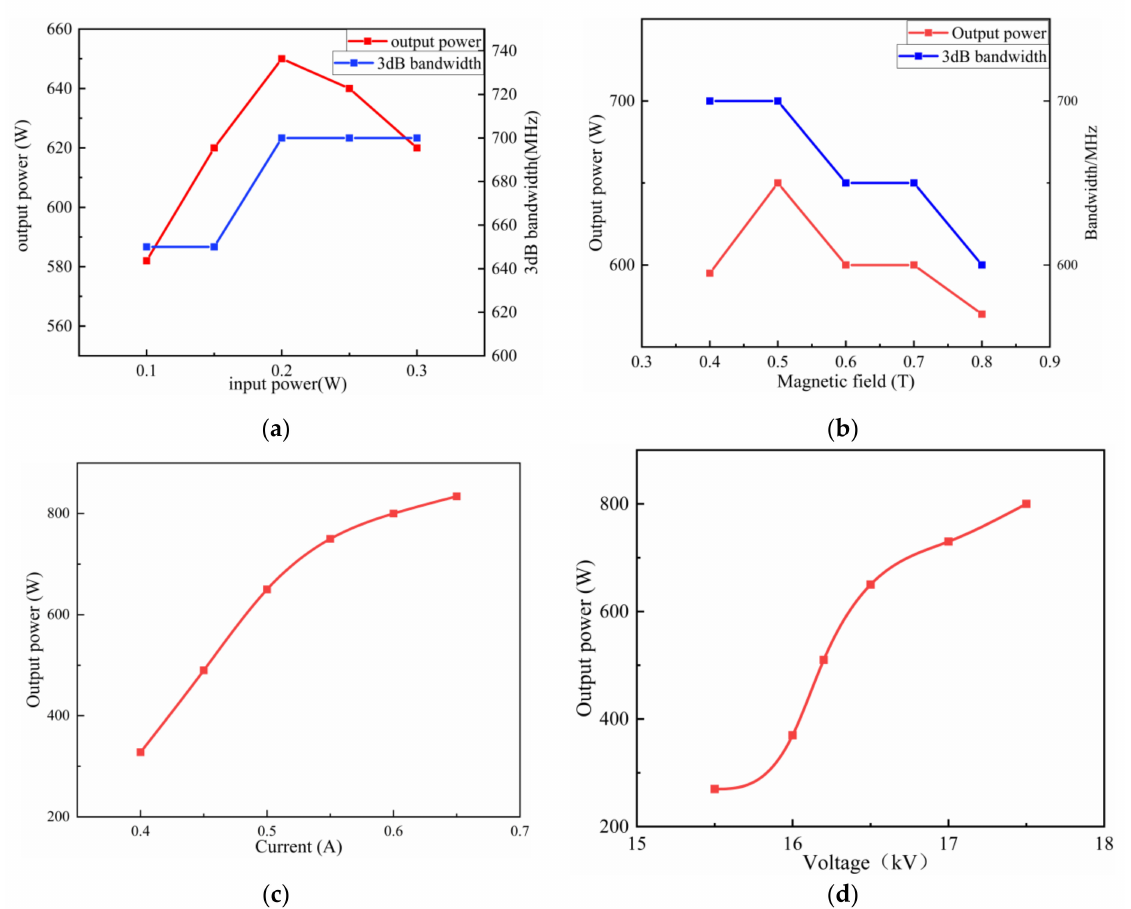
Figure 6. The variation of the output power and bandwidth with typical parameters. ( a ) The output power and 3-dB bandwidth variation with the input power, where the current (0.5 A), voltage (16.5 kV) and magnetic field (0.5 T) remain unchanged. ( b ) The output power and 3-dB bandwidth variation with the magnetic field, where the current (0.5 A), voltage (16.5 kV) and input power (0.2 W) remain unchanged. ( c ) The output power variation with the current, where the voltage (16.5 kV), magnetic field (0.5 T) and input power (0.2 W) remain unchanged. ( d ) The output power variation with the voltage, where the current (0.5 A), input power (0.2 W) and magnetic field (0.5 T) remain